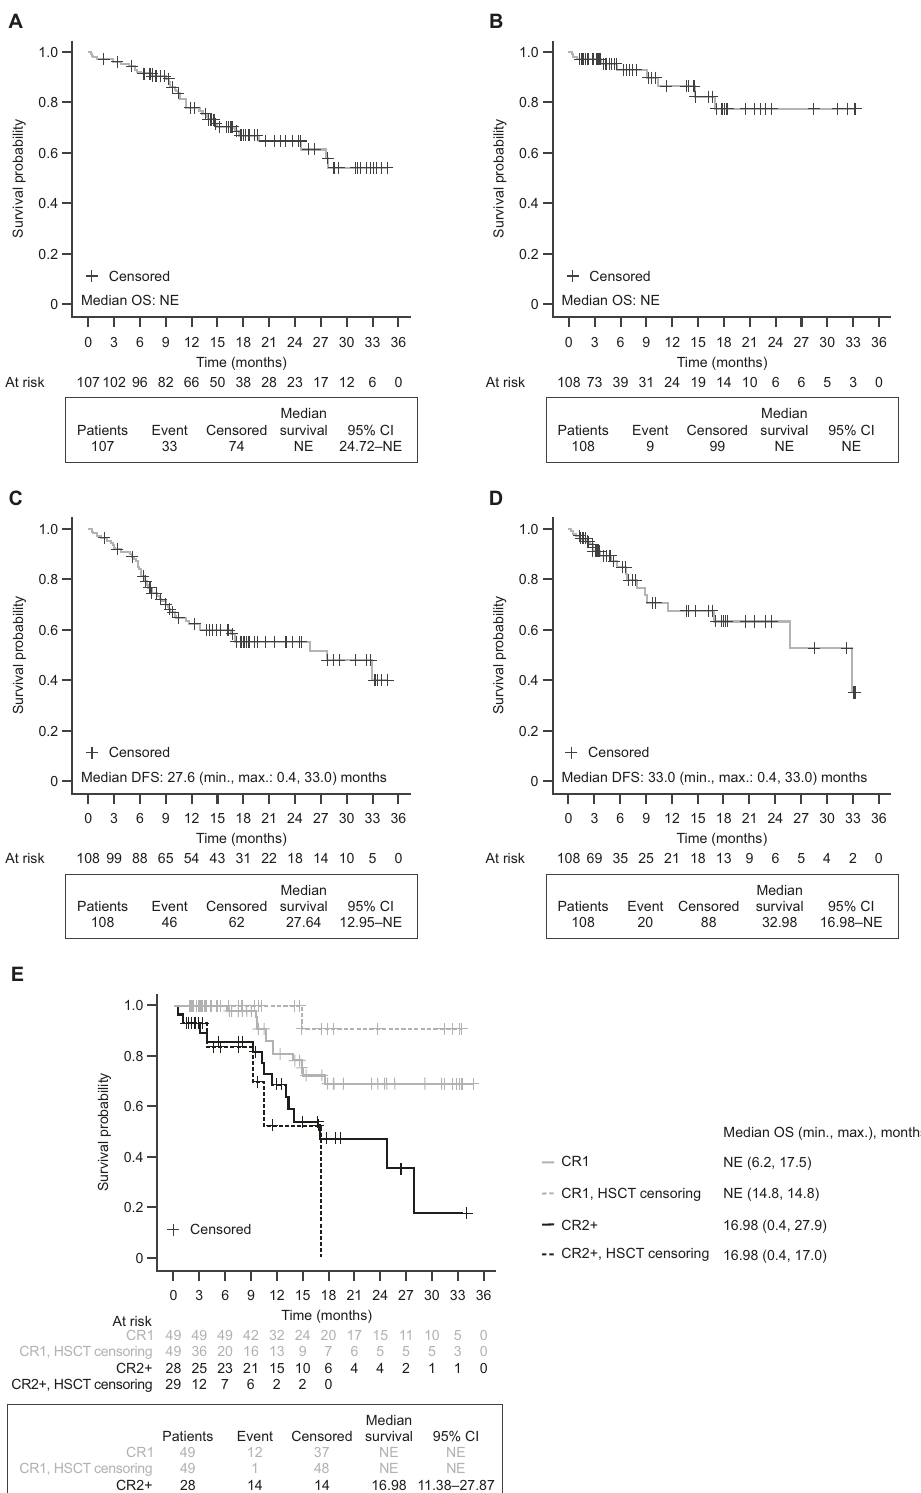
Fig. 2 KM analysis of OS and DFS in the MRD + group. A OS. B OS with additional censoring at the time of HSCT. C DFS. D DFS with additional censoring at the time of HSCT. E OS by CR1/CR2 + status with or without additional censoring at the time of HSCT. In the OS analysis, two adult patients were excluded from the crude analysis and one patient was excluded from the HSCT-censored analysis because of missing data on the date of the event. In the DFS analysis, one patient was excluded because of missing data (dates). For OS and DFS, patients were censored if they were alive at the end of the study or they were lost to follow-up. CI con fi dence interval, CR1 de fi ned patients who reached complete remission after fi rst induction therapy , CR2 + de fi ned patients who reached complete remission after one or more salvage therapies for relapsed or refractory disease, DFS disease-free survival, HSCT hematopoietic stem cell transplantation, KM Kaplan – Meier, max . maximum, min . minimum, MRD + minimal residual disease-positive, NE not estimable, OS overall